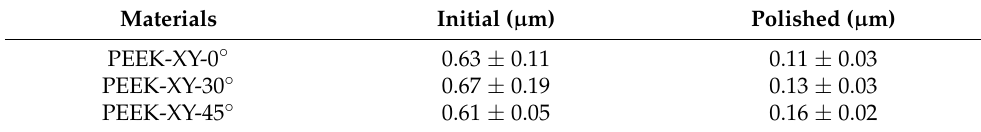
( b ) Figure 7. Tensile behaviors with varied raster angles. ( a ) Tensile stress-strain curves; ( b ) average tensile strengths against raster angle.